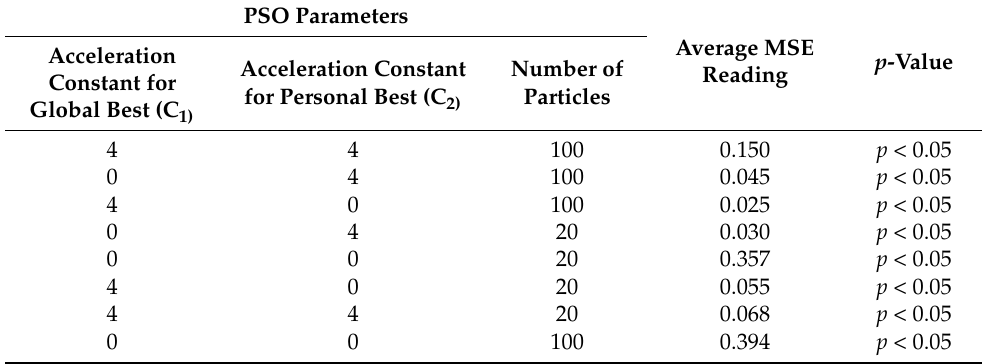
Table 2. PSO factorial design results based on 2 3 level